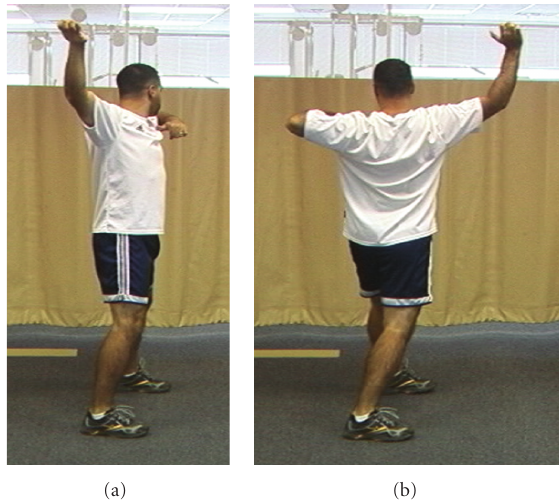
Figure 9: (a) Power position begins with the dominant arm in the 90/90 position and forearm pronated. (b) Next, while maintaining the 90/90 arm position, rotate the trunk forward to simulate the throwing motion phases of acceleration to ball